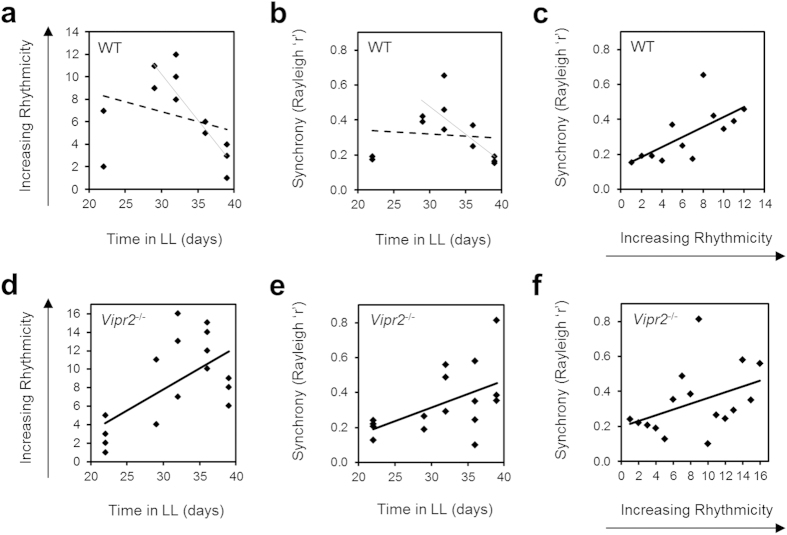
Relationships between time in LL, behavioral rhythmicity and SCN cellular synchrony for WT and Vipr2−/− mice.Vipr2−/− data describe a three-way positive correlation between increasing time in LL, greater behavioral rhythmicity and increasing SCN cellular synchrony (d–f). For WT mice, behavioral rhythmicity positively correlates with SCN cellular synchrony (c). Conversely, the relationships of both of these parameters with time in LL for WT mice are poorly fit by linear trends (broken lines on panels a,b) but ultimately result in a progressive decrease in both rhythmicity (a) and synchrony (b) after extended (>29 days) durations of LL (light unbroken lines added for visual reference; though see main text for statistical assessment of these subsets of data for >29 days in LL). Data in panels c–f are shown fitted with linear trend lines (heavy unbroken lines) that provided high goodness of fit and illustrate a linear relationship of ranked data in each case (all data sets in panels (c–f) show significant correlations; Spearman’s rho = 0.755 (p = 0.0025) (c), 0.522 (p = 0.038) (d), 0.6 (p = 0.007) (e) and 0.512 (p = 0.0215) (f)).